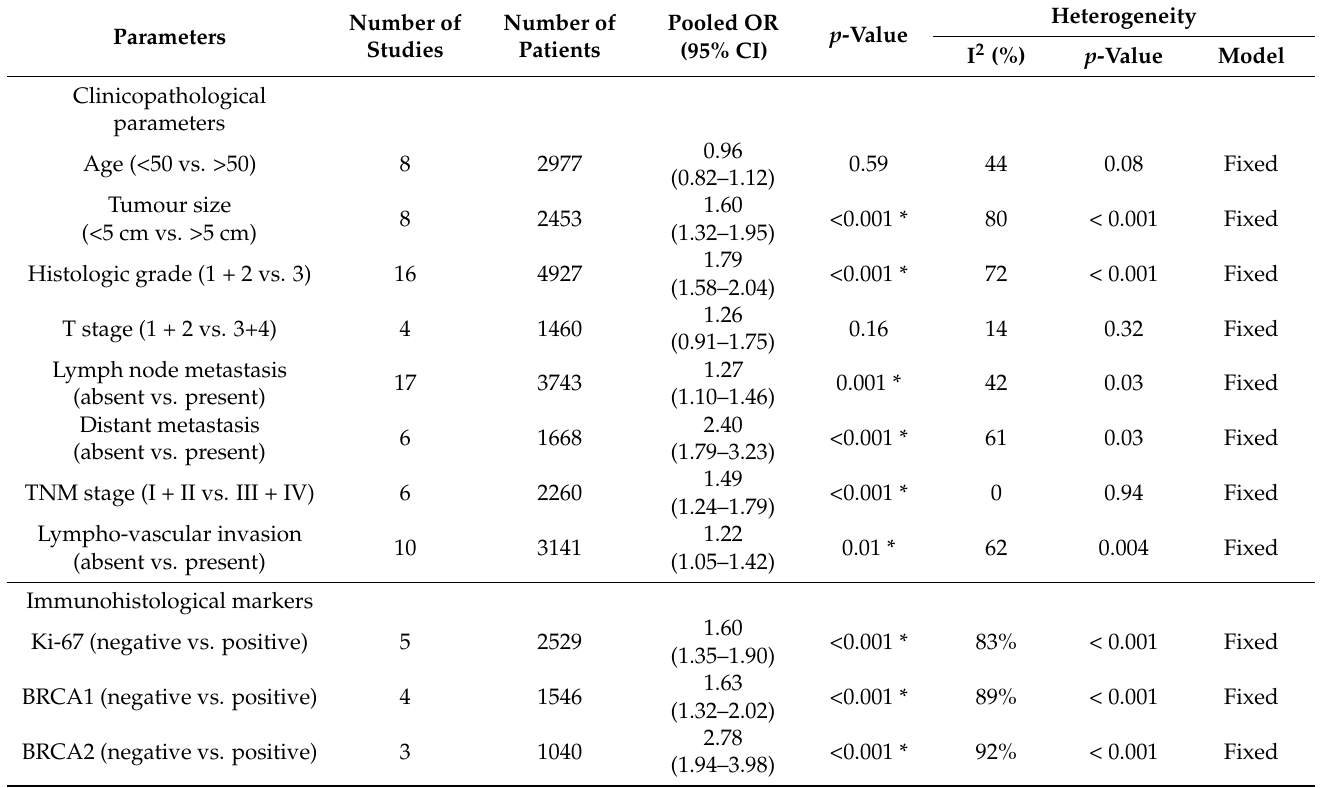
Table 3. The association of PARP expression with the clinicopathological and immunohistochemical parameters.